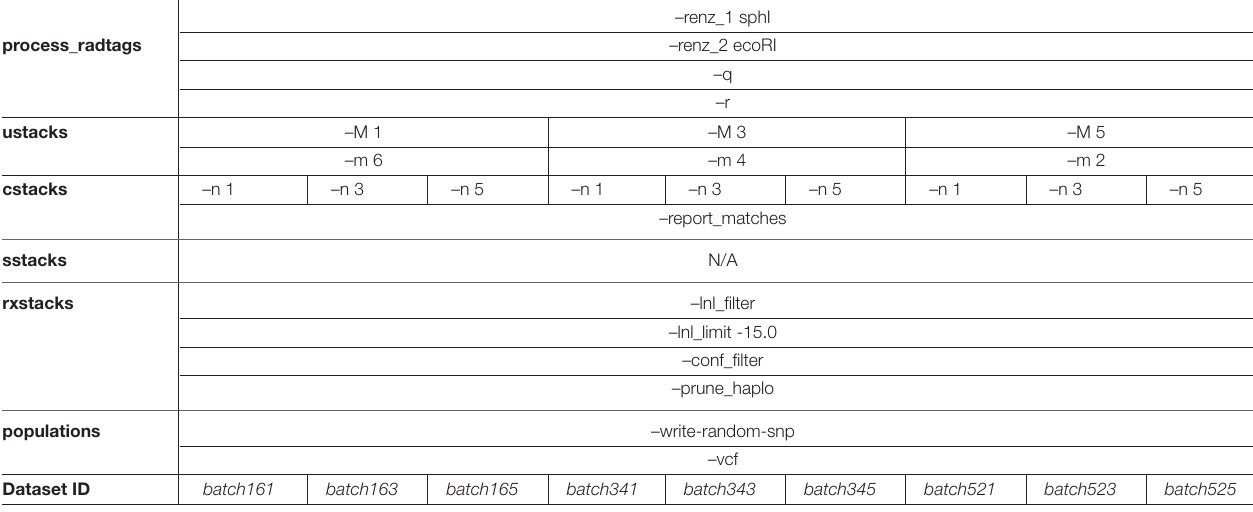
TABLE 1 | Details of data assembly in STACKS v1.45 are provided below, including flags and settings used at every step of the